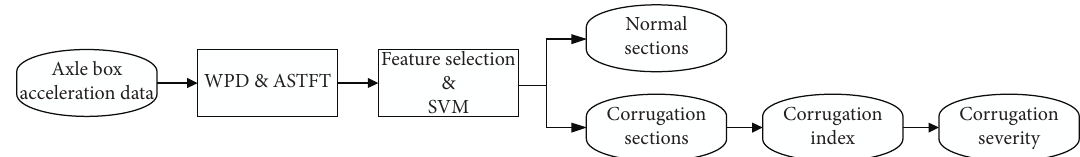
Figure 2: Flowchart of the corrugation detection method.